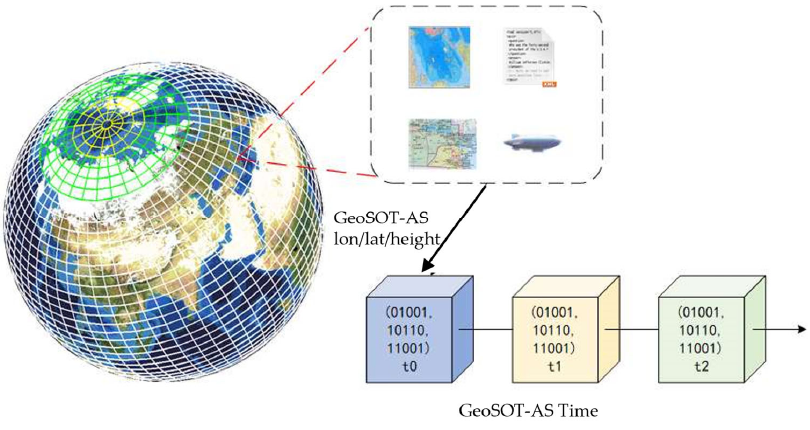
Figure 7. Data representation under GeoSOT ‐ AS model.